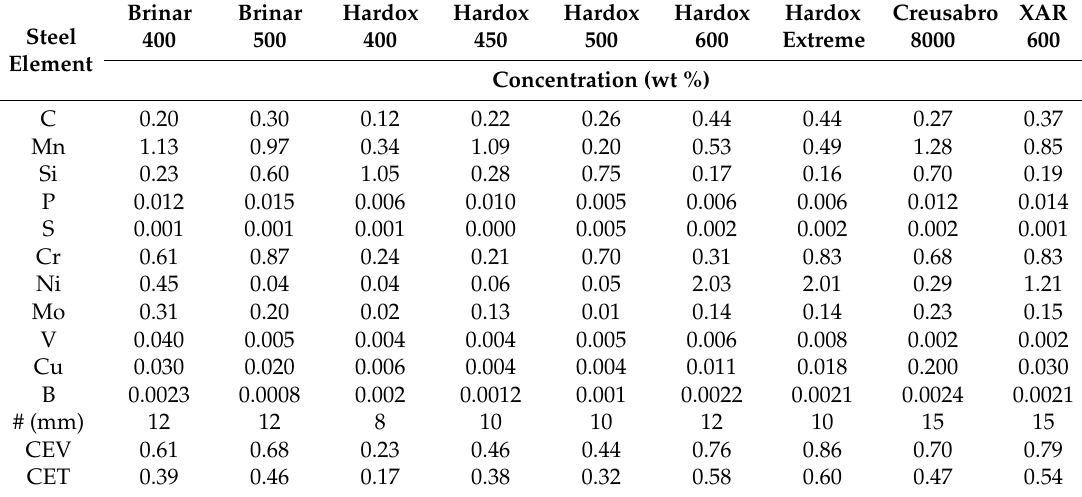
Table 3. Real chemical compositions and calculated carbon equivalents of selected low-alloy steels in the form of 8–15 mm thick sheets